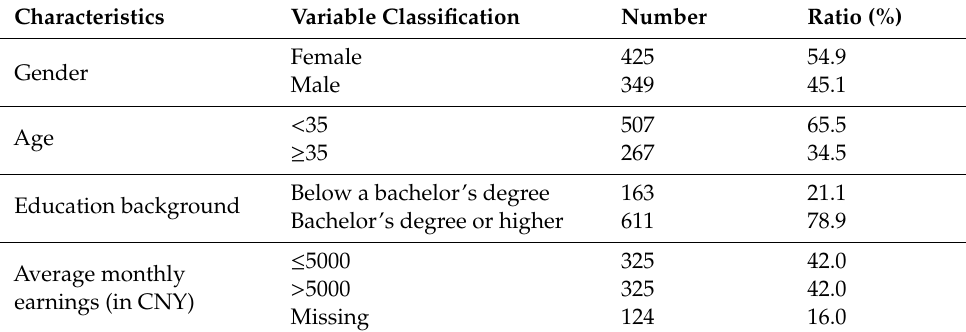
Table 2. Demographic characteristics of consumers ( N =